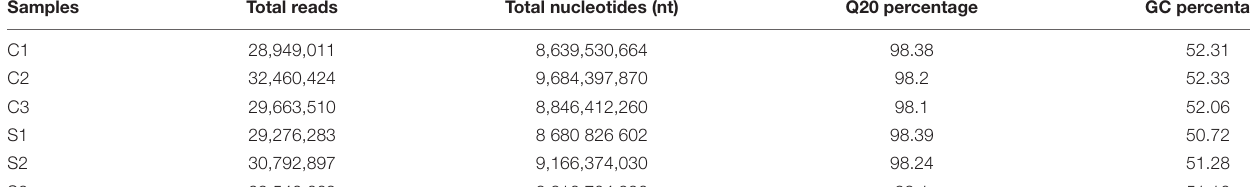
TABLE 2 | Statistics of raw data for BD banana transcriptome. Samples